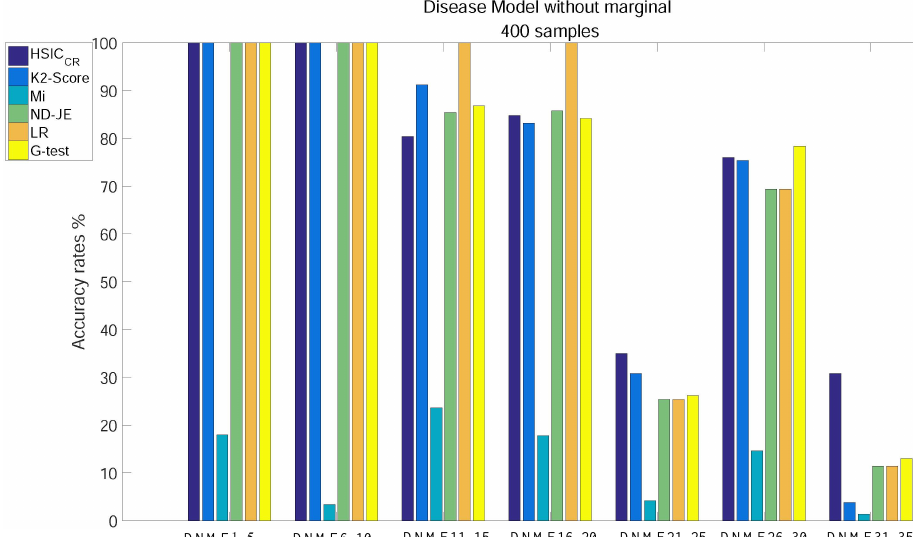
Figure 3. Disease model without marginal effects, with 400 samples and with k = 2.